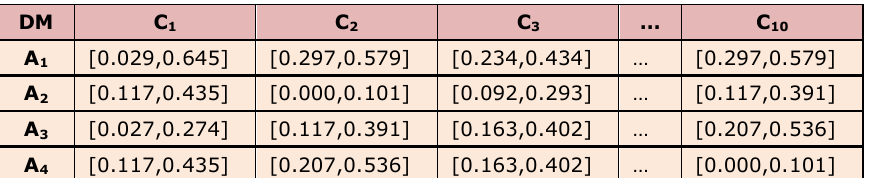
Table 4. The normalized interval decision matrix